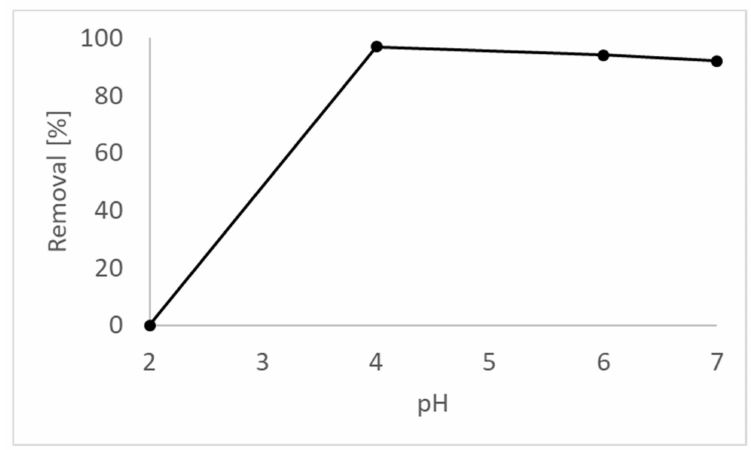
Figure 1. The removal percentage as a function of pH. Experiments were done in duplicate and the range of results were at maximum 3 percentage points.